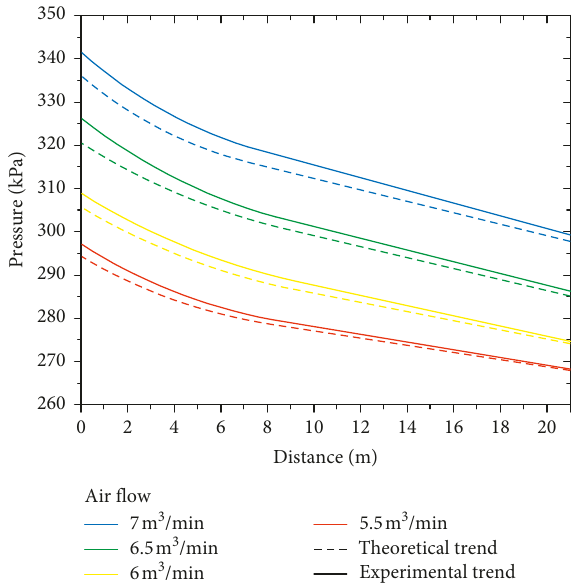
Figure 11: Comparison of pressure drop in the accelerate zone.